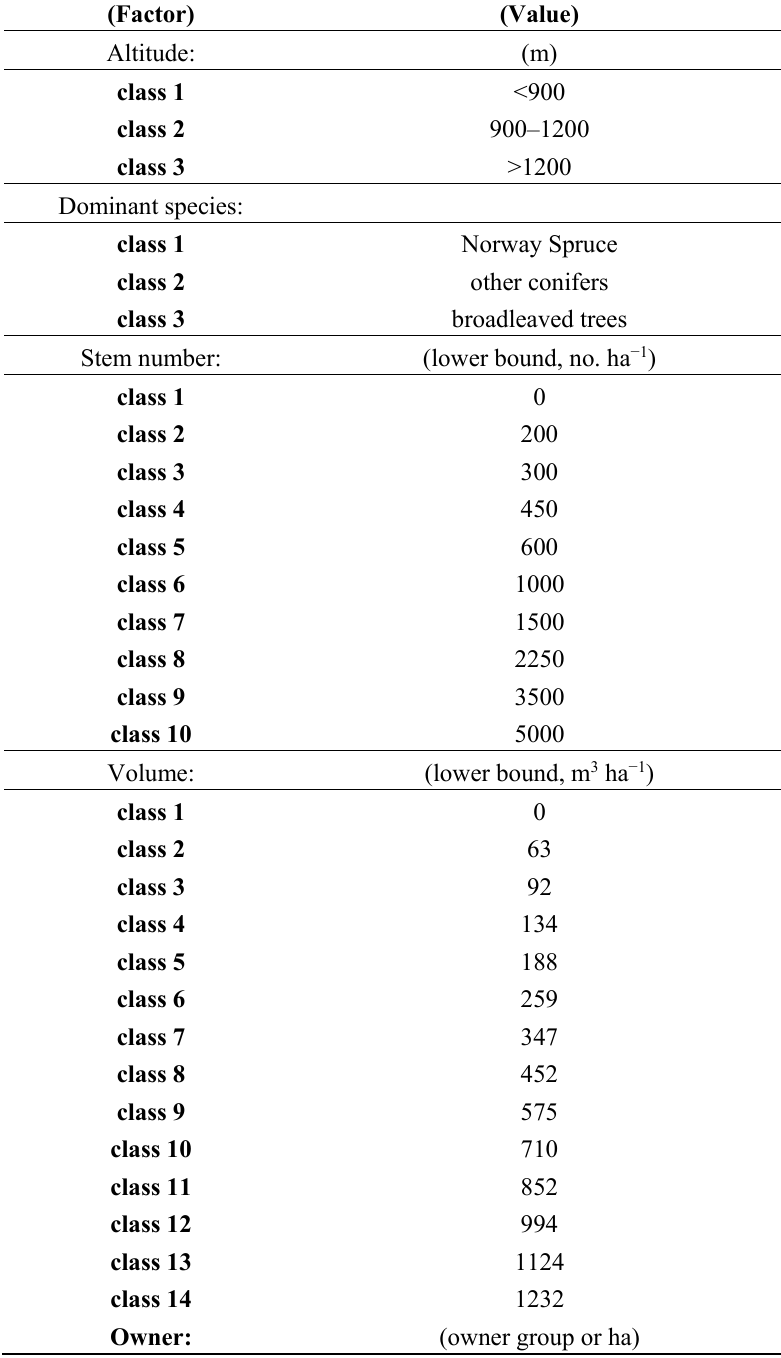
Table A1. The different classes for forests were defined as